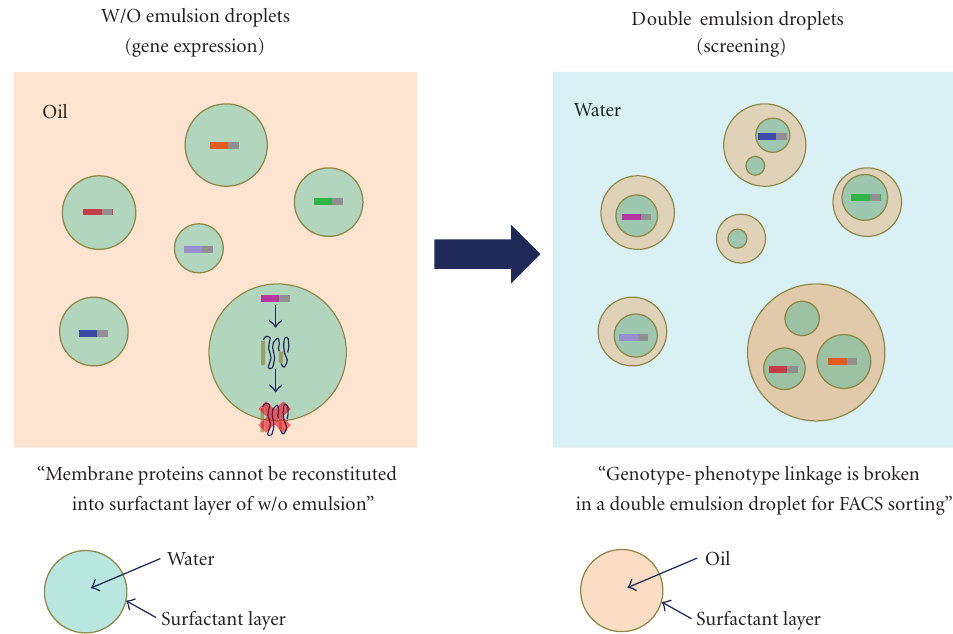
Figure 3: The technical limitations of emulsion-based IVC due to the “W/O emulsion” and “double emulsion” structures.